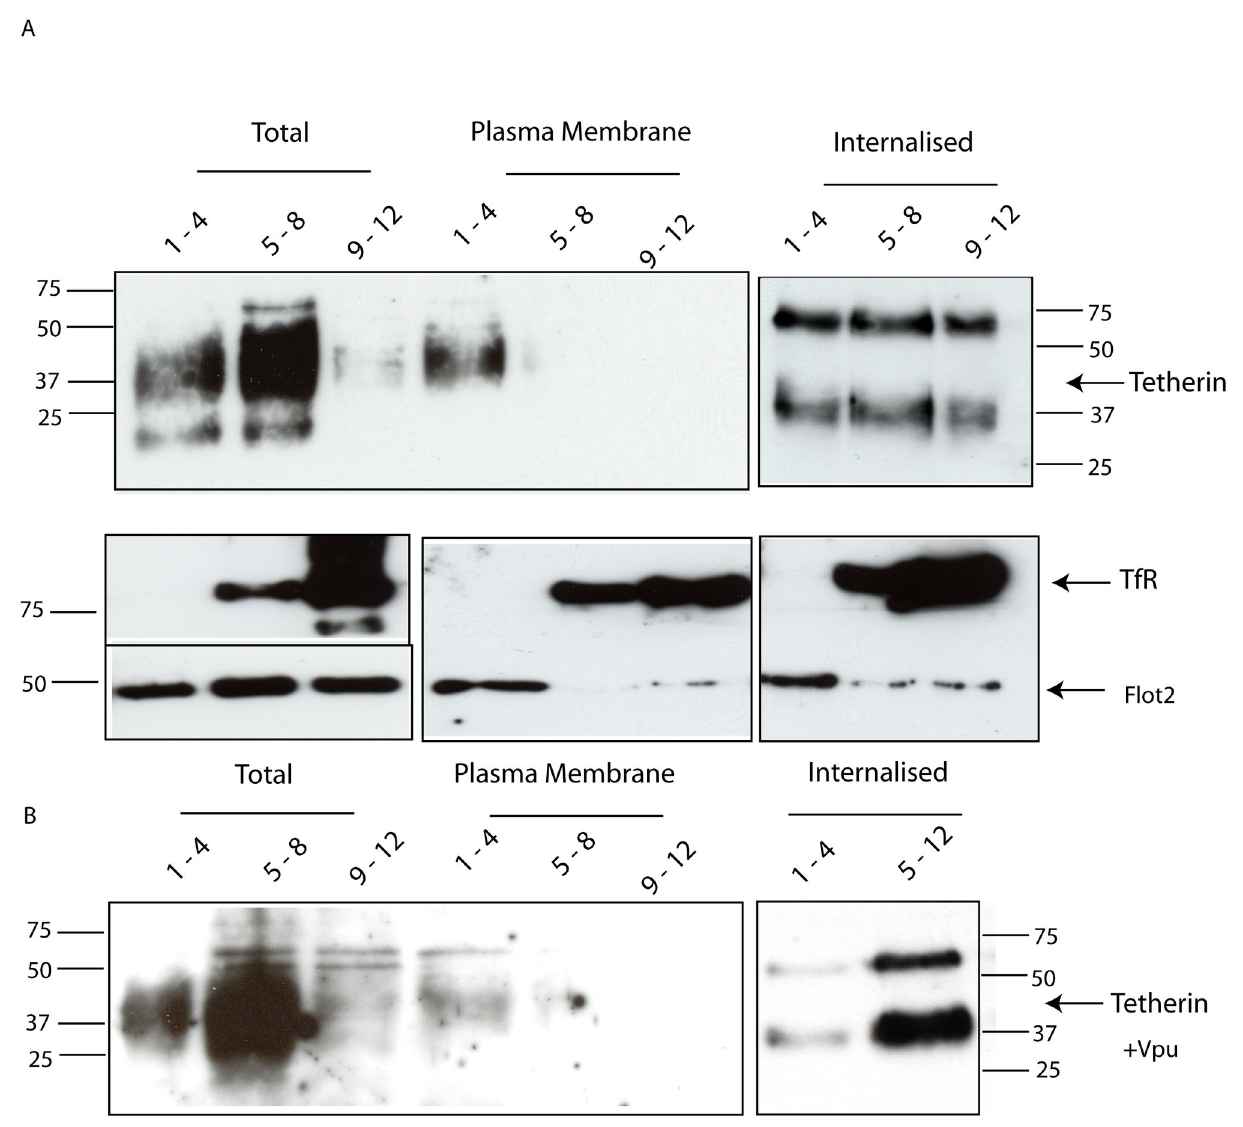
Figure 4. Tetherin is in lipid rafts at the cell surface. A . HeLa cells were labeled with a membrane impermeant biotin reagent at 4°C prior to either immediate lysis in ice cold Triton X-100, or incubation for 10 min at 37°C before lysis in ice cold Triton X-100. Lysates were then separated on sucrose density gradients and 1 ml fractions were taken. Fractions 1-4 were pooled as raft fractions, 5-8 and 9-12 as two separate non-raft fractions. Lysates were then incubated with streptavidin-agarose beads to separate biotinylated (cell surface in the case of immediate lysis after biotinylation at 4°C, or internalised in the case of the 10 min chase at 37°C, proteins) from non-biotinylated proteins. Total, plasma membrane, and internalised fractions were then subjected to immunoblot analysis using antibodies to endogenous tetherin, Transferrin receptor or Flotillin 2 (the latter two as controls) as indicated. The total population of tetherin molecules is ~ 35% raft localized (1-4 in Total), however the tetherin that is at the cell surface (i.e. the biotinylated tetherin at 0 min uptake at 37°C) is almost exclusively raft localized (1-4 in Plasma Membrane). After 10 min uptake at 37°C a significant proportion of biotinylated tetherin is present in non-raft fractions (Figure 4A Internalised). B . As in A, but using HeLa cells transfected to express Vpu-GFP.